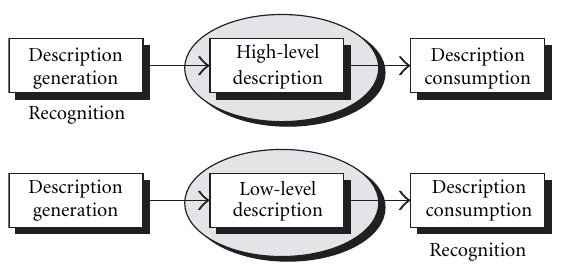
Figure 11: Localization of the recognition process depending on the feature